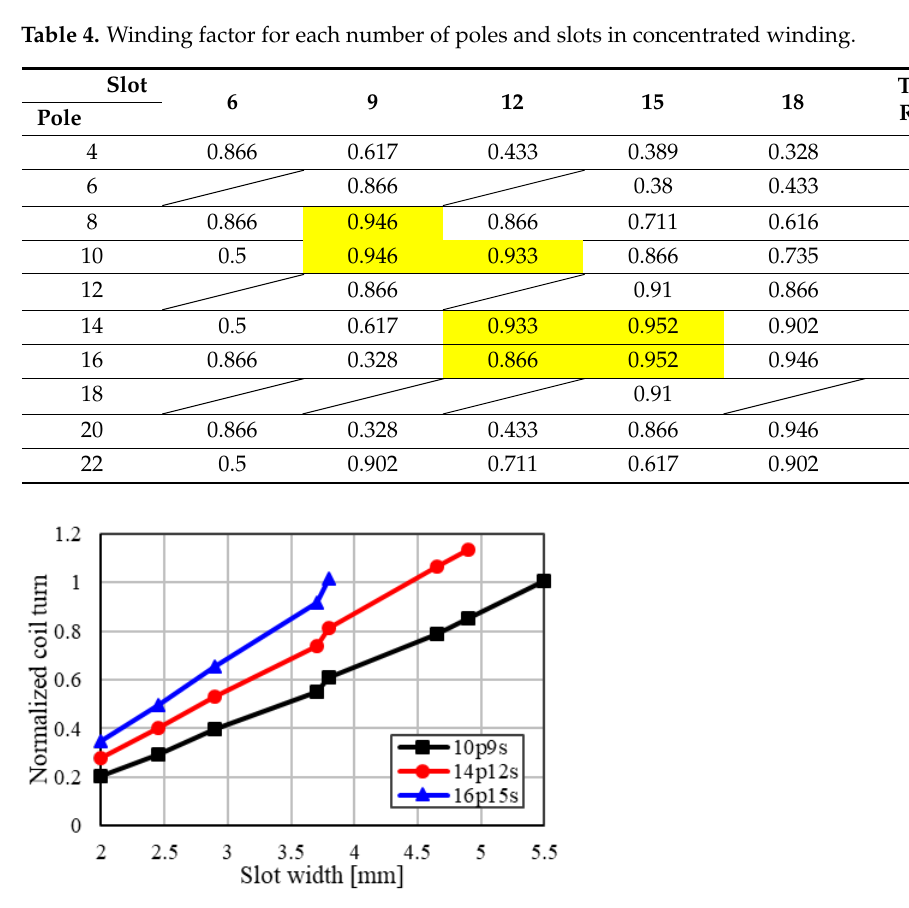
Figure 11. Number of coil turns with respect to slot width.